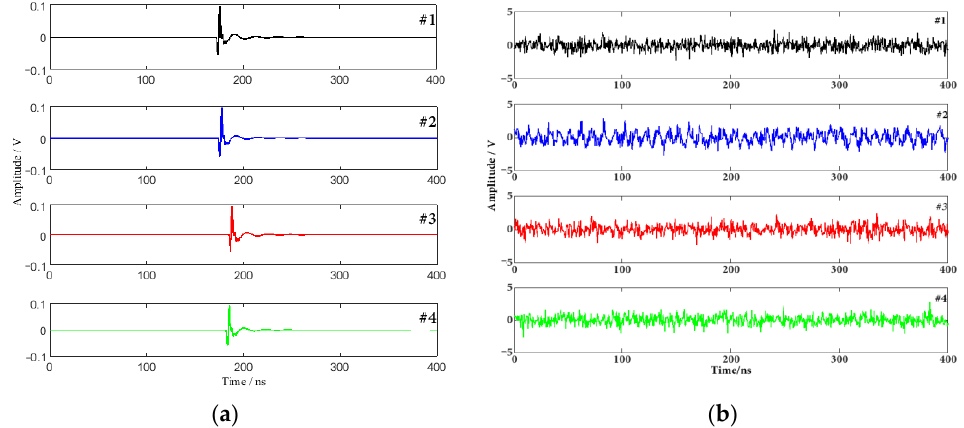
Figure 3. Time-domain waveform of simulated PD signal, ( a ) PD signal without noise; ( b ) PD signal mixed with Gaussian white noise and narrow-band noise.